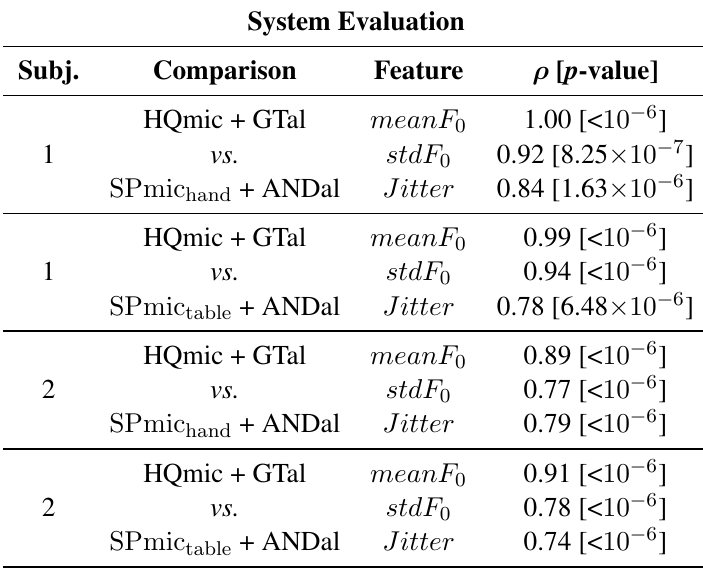
Table 6. Overall estimation of the system. Correlation coefficients regarding the investigation about the features extracted from audio coming from the two different systems: HQmic + GTal vs. SPmic + ANDal and HQmic + GTal vs. SPmic hand corresponding p -values are shown in